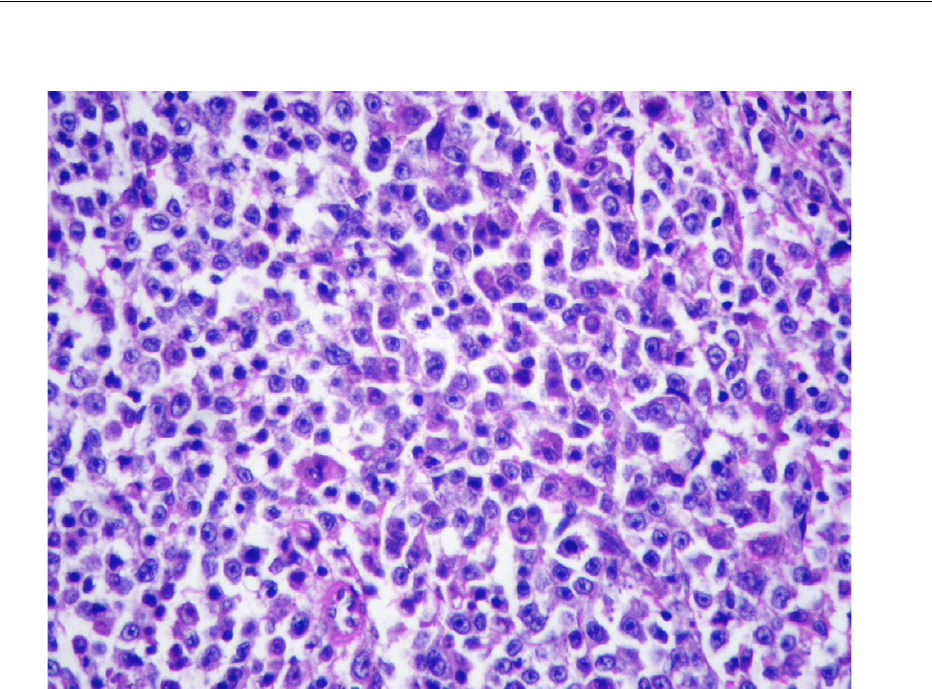
×400).Morphology of Splenic marginal zone lymphoma Figure 3 Morphology of Splenic marginal zone lymphoma. Characteristic micronodular pattern in the SMZL centred in the white pulp, with variable red pulp infiltration (H&E, original magnification